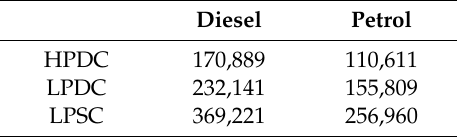
Table 13. BED (km) vs. CISC for various types of engine blocks and manufacturing processes.